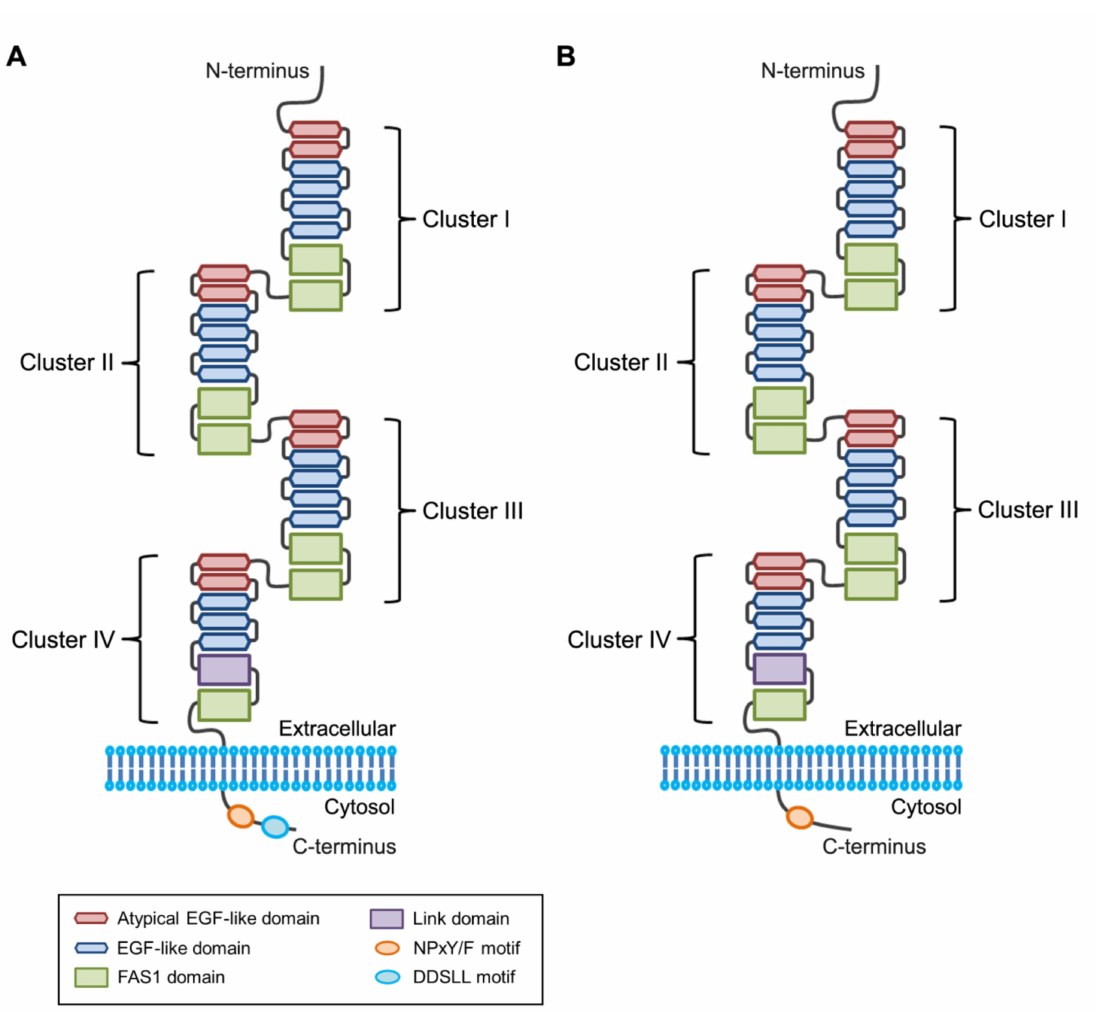
Figure 1. Structure of stabilin receptors. The extracellular regions of stabilin-1 ( A ) and stabilin-2 ( B ) are composed of four clusters containing epidermal growth factor (EGF)-like domain repeats, which bind to phosphatidylserine on the apoptotic cell surface. The crystal structure of fasciclin I (FAS1) domain of stabilin-2 has recently been determined [55]. The cytosolic region of stabilin-1 contains an asparagine-proline-x-phenylalanine (NPxF) motif (where x is any amino acid) and a aspartate-aspartate-serine-leucine-leucine (DDSLL) motif, whereas the cytosolic region of stabilin-2 contains an asparagine-proline-x-tyrosine (NPxY) motif (where x is any amino